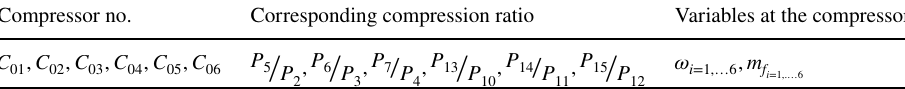
Table 2 Compressor notation Compressor no. Corresponding compression